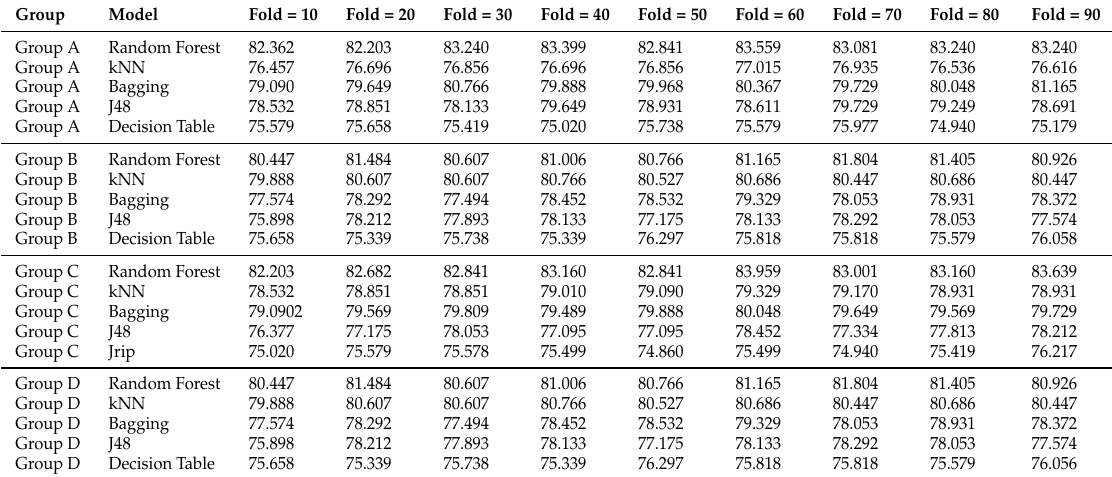
Table 6. Correctly classified instances where PCC > 75% for each classification algorithm for all groups using k-fold cross-validation (Train 90% : Test 10%).